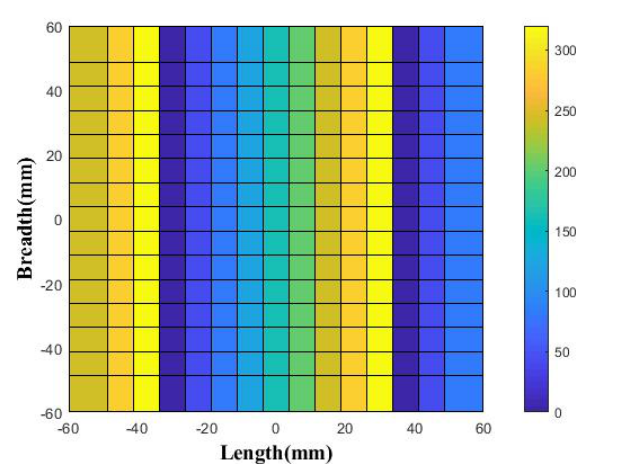
Figure 9. Phase distribution of CRS for the designed four-layer